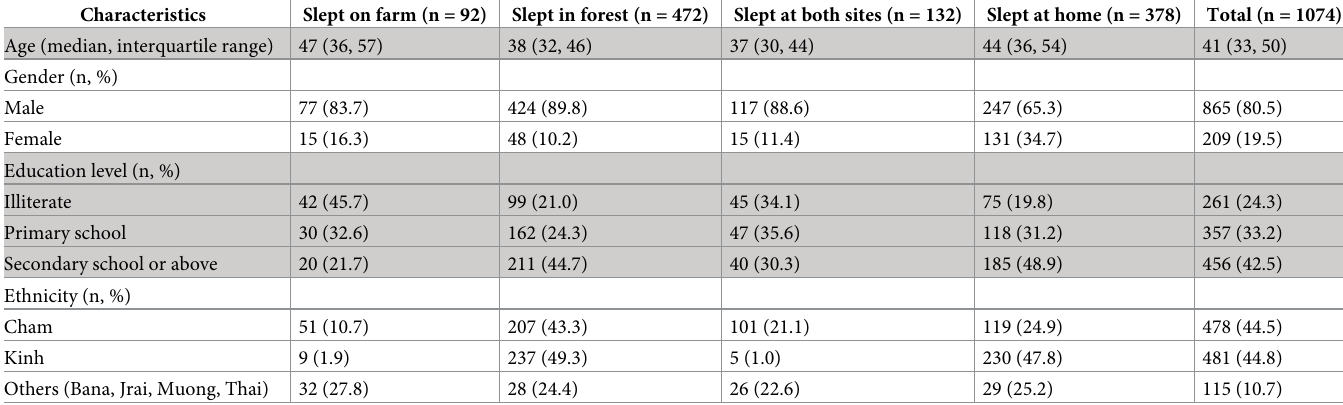
Table 1. Socio-demographic characteristics of primary household respondents (heads of household) by sleeping site in Dong Xuan District, Phu Yen Province, 2016.